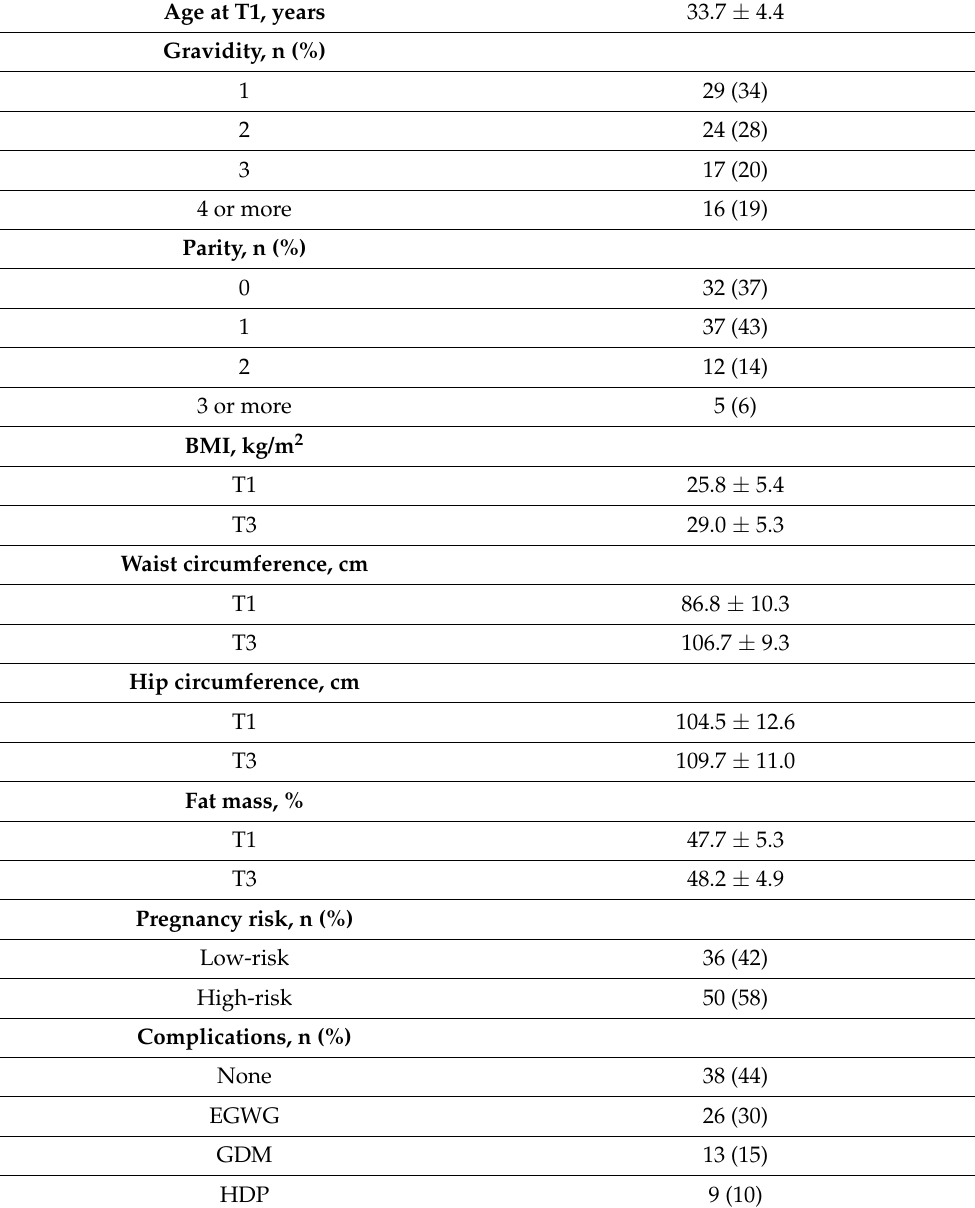
Table 1. Characteristics of the 86 participants included in this MUMS cohort